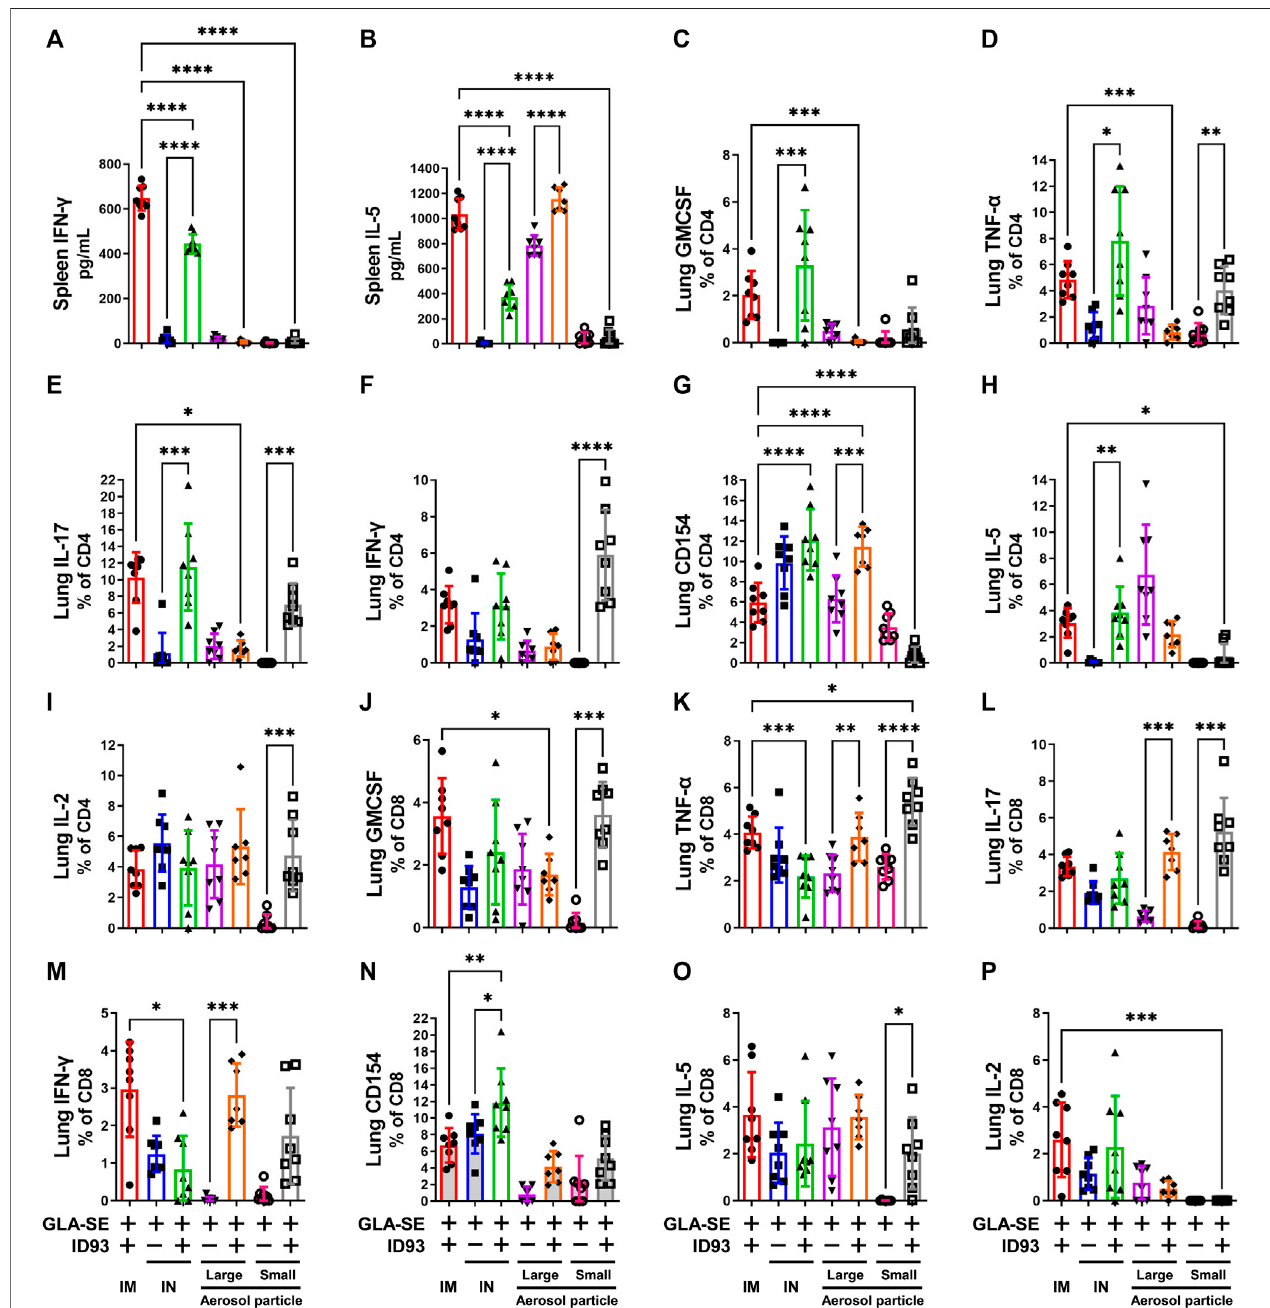
FIGURE 5 | IM, IN, and aerosol vaccinations with ID93+GLA-SE induce cellular immune responses in vaccinated mice. B6 (n (cid:1) 7 – 8) mice were either vaccinated with ID93+GLA-SE or only GLA-SE through intramuscular (IM), intranasal (IN), nasal aerosol delivery of large particle dry powder, or pulmonary aerosol delivery of small particle dry powder, at day 0 and day 21. Mice spleens were harvested at 4 weeks post fi nal immunization and stimulated with ID93 antigen (2 μ g/ml for 48 h). Levels of splenic (A) IFN- γ and (B) IL-5weredetectedinthesupernatantbyELISA.SplenocyteELISAdatashownarefromoneexperiment,andsimilarpatternsofresponse were evident in the repeat experiment. Frequency of (C) CD4 + GMCSF + , (D) CD4 + TNF- α + , (E) CD4 + IL-17 + , (F) CD4 + IFN- γ + , (G) CD4 + CD154 + , (H) CD4 + IL-5 + , (I) CD4 + IL-2 + , (J) CD8 + GMCSF + , (K) CD8 + TNF- α + , (L) CD8 + IL-17 + , (M) CD8 + IFN- γ + , (N) CD8 + CD154 + , (O) CD8 + IL-5 + , and (P) CD8 + IL-2 + T cells in the lung were detectedusing fl owcytometry. Micelungs wereharvestedat 4 weekspost fi nalimmunizationfordetection ofimmunecellcomponents.Flowcytometry datashown are from one experiment and were not repeated in the second mouse experiment. For both fl ow cytometry and ELISA readouts, responses in unstimulated controls were subtractedfromthestimulatedsamples,andanyresultingnegativevalueswereassignedaszero.* p < 0.05,** p < 0.01,*** p < 0.001,and p < 0.0001byone-wayANOVA orWelch ’ sANOVAwithSidak ’ sorDunnet ’ sT3correction,respectively,formultiplecomparisonsbetweenselectedgroups.TheKruskal-Wallisnon-parametrictestwith Dunn ’ s correction for multiple comparisons was used when multiple comparisons were not possible with Welch ’ s ANOVA due to one experimental group having constant values.